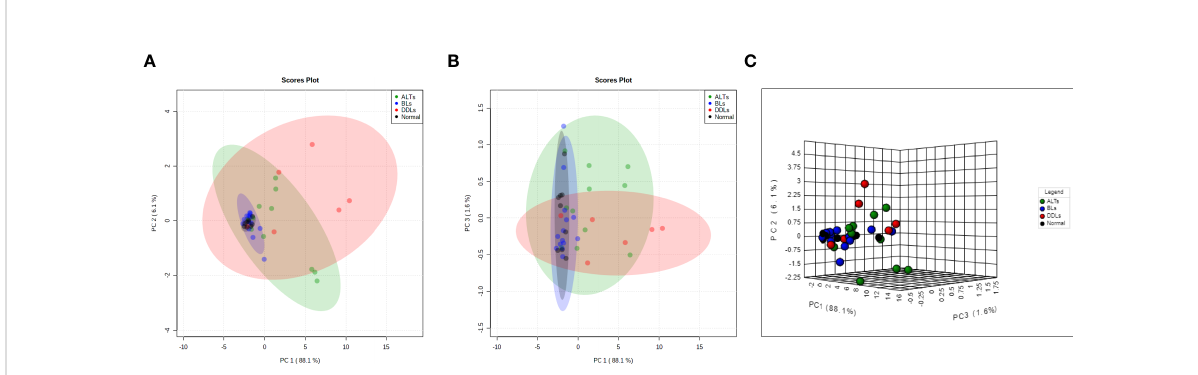
FIGURE 5 Score plots derived from principal component analysis (PCA) of the MR spectra. Two-dimensional PCA representation of the score plot showing differential clustering of each group. Two-dimensional score plot (A) PC1 vs PC2, (B) PC1 vs PC3 and (C) three-dimensional score plot. PC1 vs PC2 vs